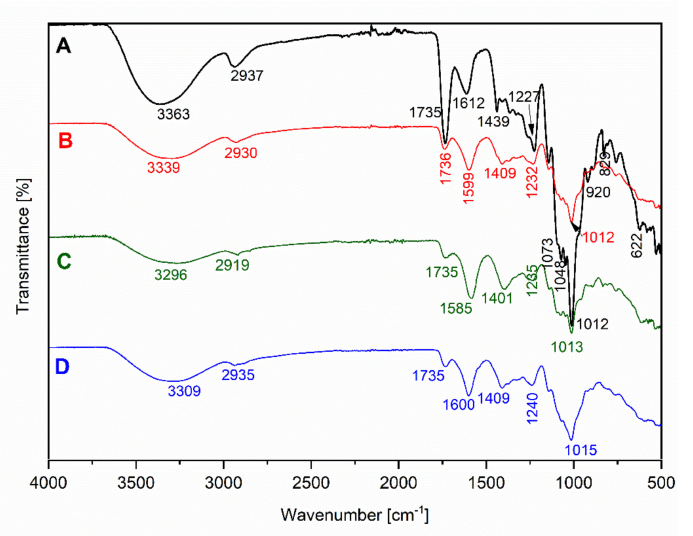
Figure 2. FT-IR spectra of commercial PectaSol-C preparation ( A ) endo-cellulase ( B ), endo-xylanase ( C ), and pectin extracted with cellulase and xylanase ( D